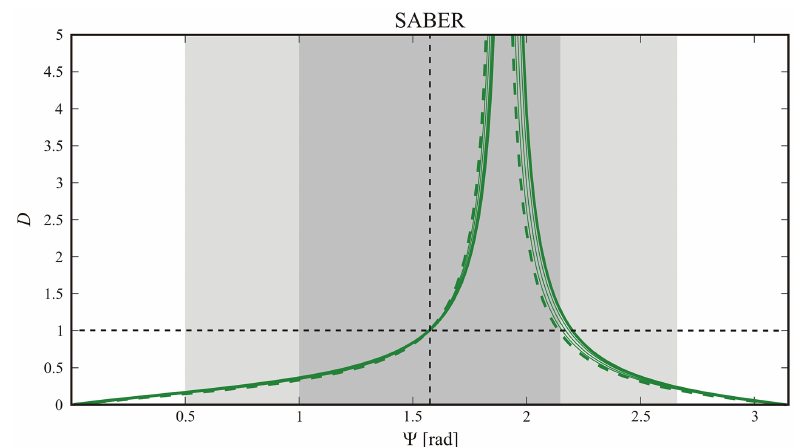
Figure 8. The same as Fig. 7, but for SABER measurements, within the considerably narrower α bounds [0.32–0.34] rad than for the GPS- RO setup, according to Fig. 5. These lower and higher bounds are indicated by thick dotted and full green lines, respectively. The “forbidden SABER sectors” are any sectors excepting those covered by green